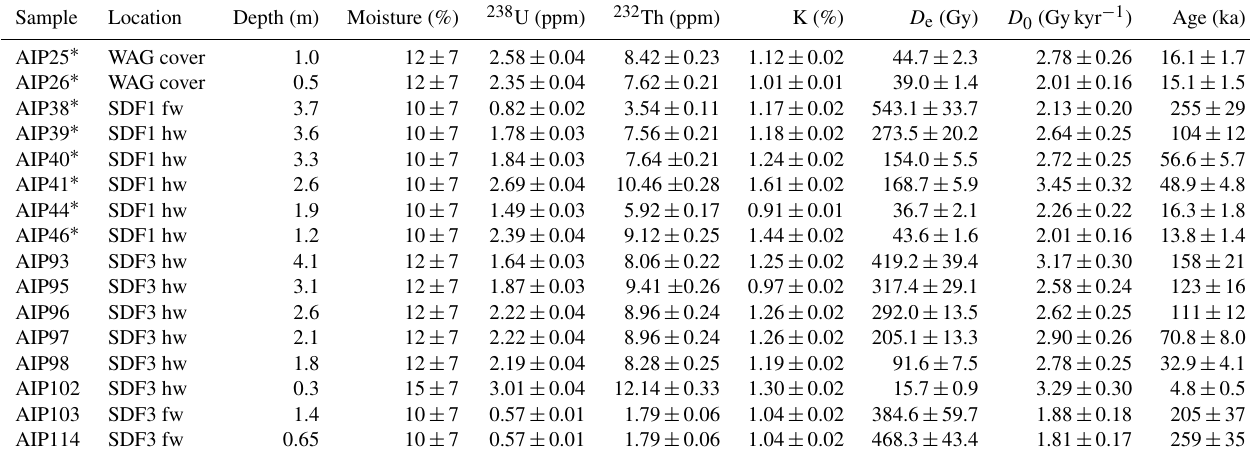
Table 1. Infrared stimulated luminescence dating results from the trenches SDF1, SDF3, and WAG at the Markgrafneusiedl Fault (MF).